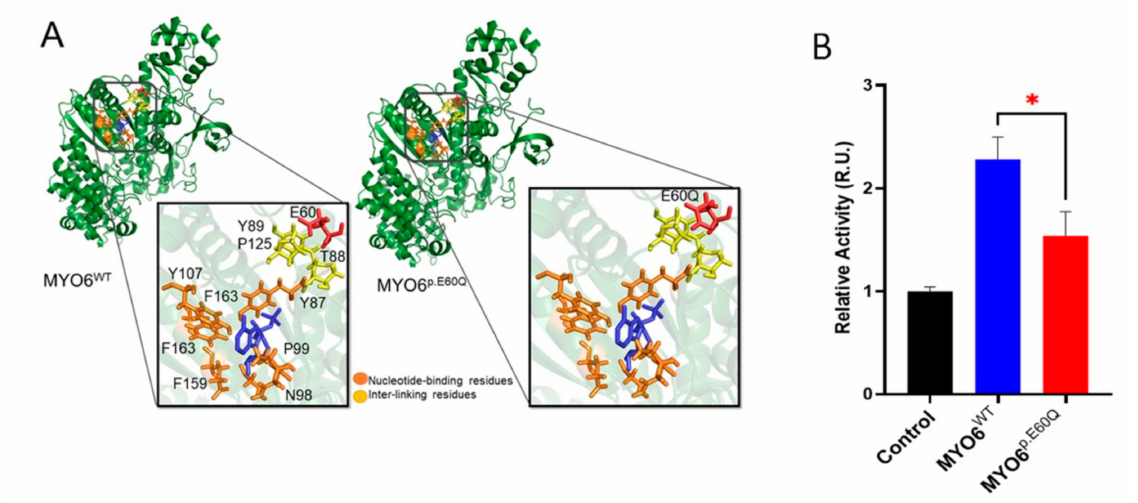
Figure 2. ( A ) Molecular protein structure of the motor domain of MYO6 showing E60 and the p.E60Q variant. ( B ) ATPase activity assay of whole-cell lysates from transfected HeLa cells with plasmids carrying human MYO6 WT and MYO6 p.E60Q . Enzyme activity was measured using a mala- chite green-based colorimetric assay. Values are represented as the mean ± SEM from independent experiments. Statistically significant differences were assessed by unpaired t -test, * p <